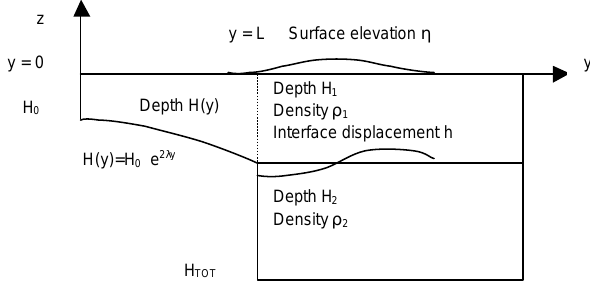
Fig. 12. Approximation of the across shore section used in the cal- culation of the free coastal trapped